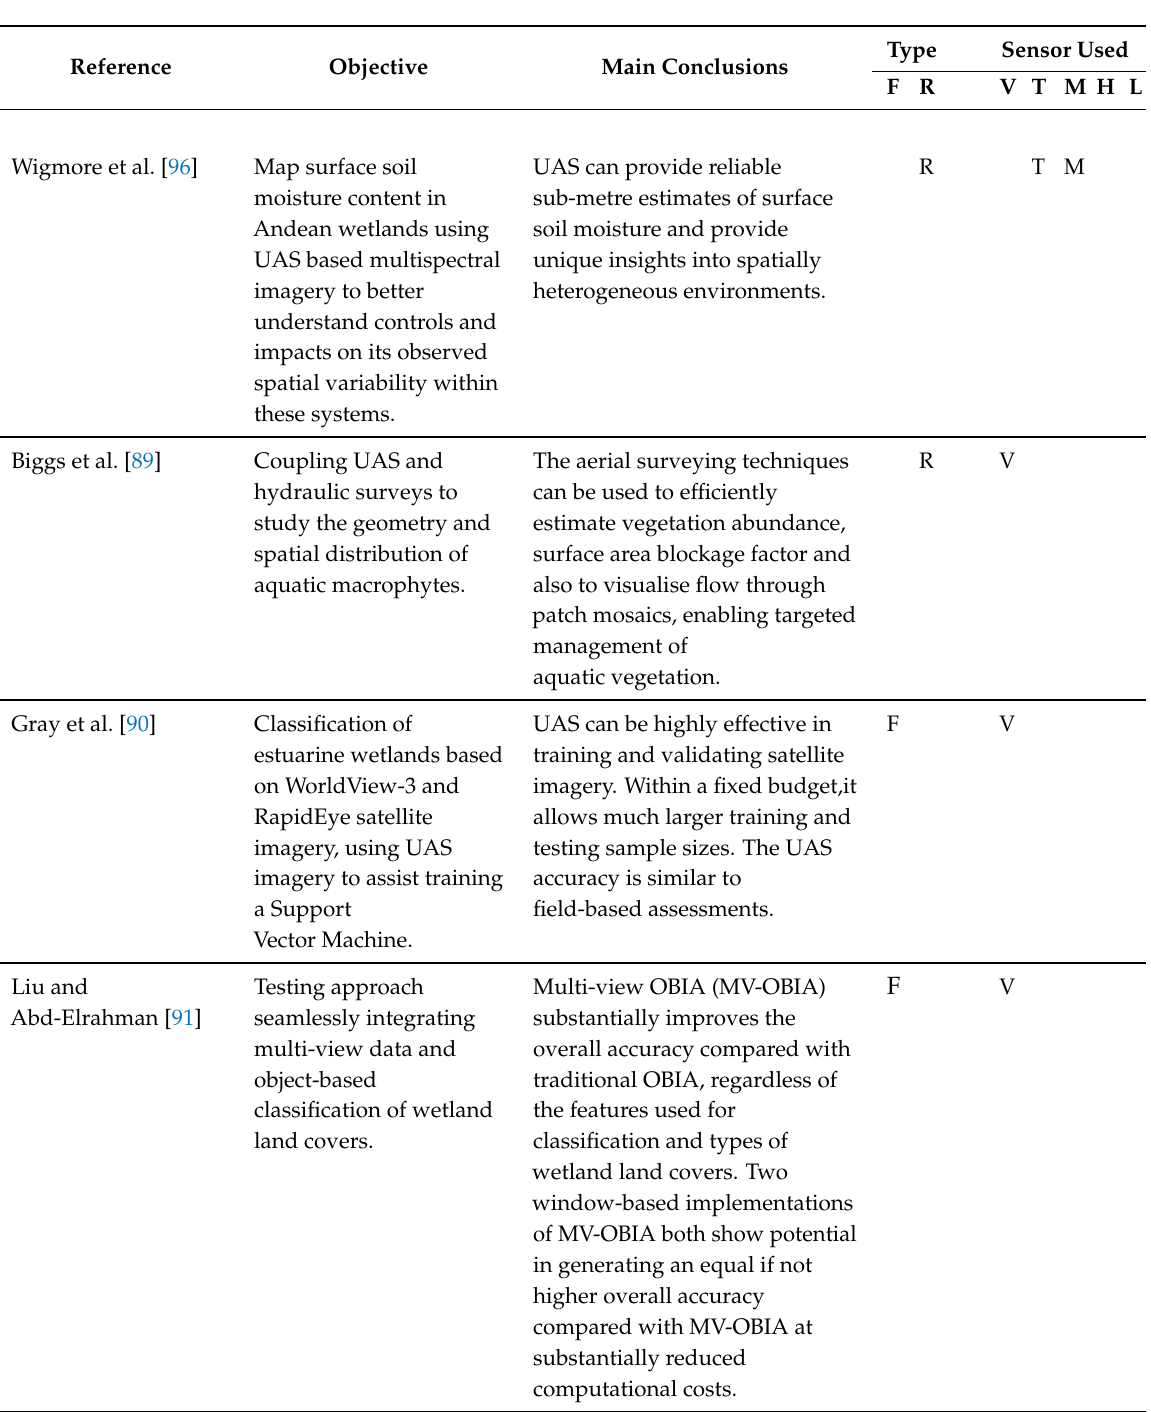
Table 8. Compilation of hydrological and environmental studies presenting their respective main objectives and conclusions and UAS type and sensors used in each case. F—fixed wing, R—rotary wing, V—visible range, T—thermal, M—multispectral, H—hyperspectral,